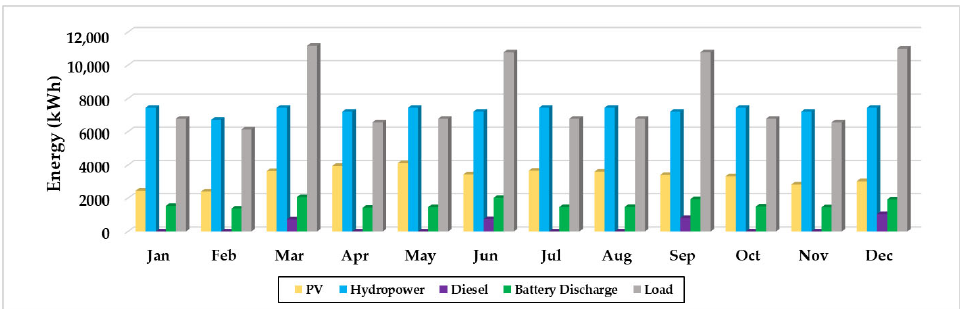
Figure 17. Energy generated by HREM components—Solution C.